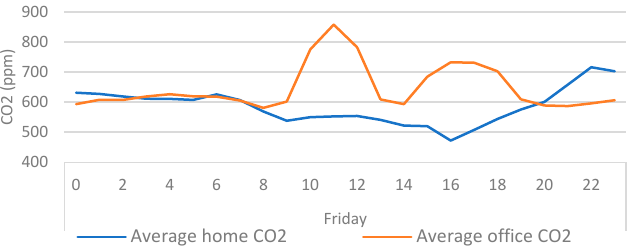
Figure 10. Average home/office CO 2 categorised by day > hour for an average Friday. Qualitative findings are displayed alongside the quantitative data for context.